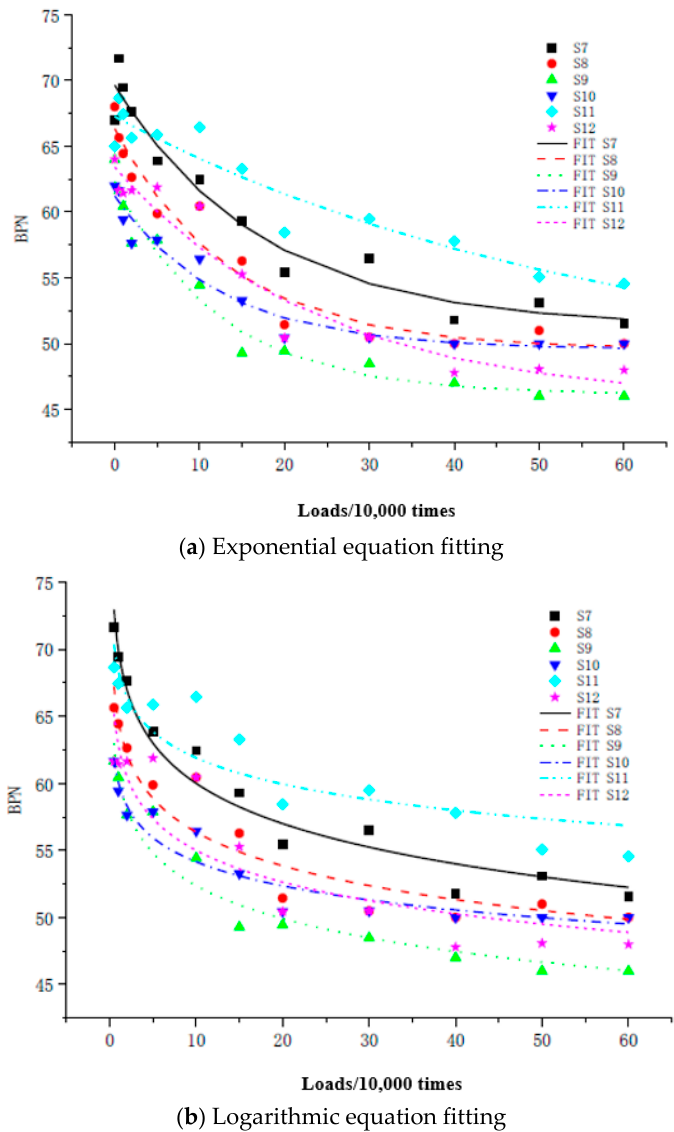
Figure 10. Pendulum friction coefficient attenuation fitting curve (SMA).